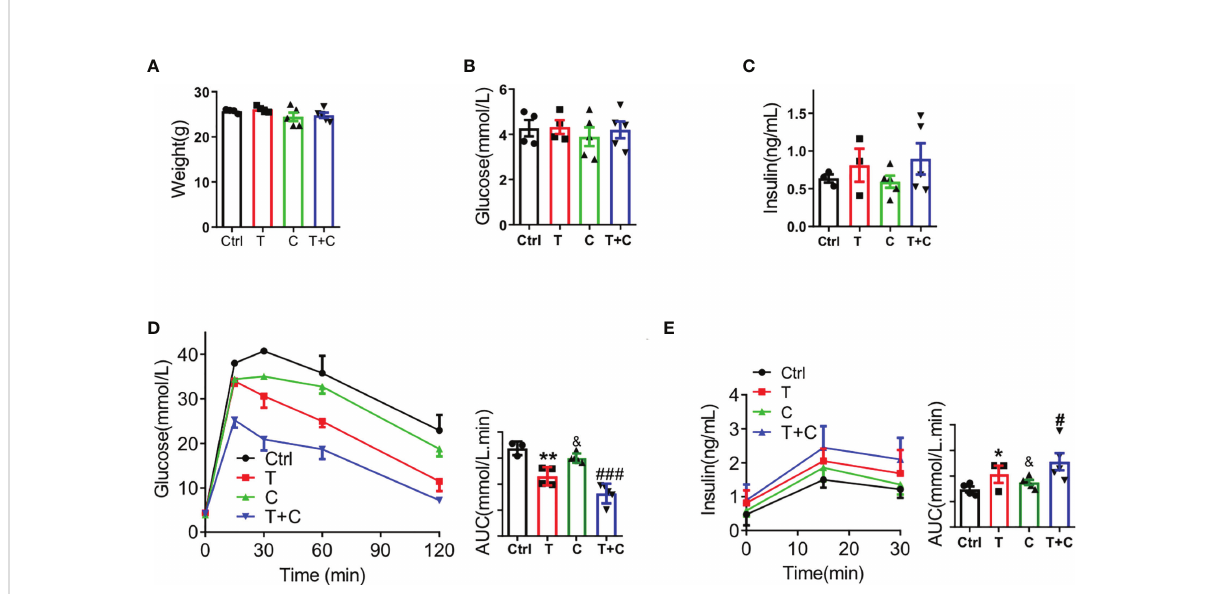
FIGURE 1 Cisapride combined with tolbutamide regulated glucose metabolism in wild-type mice Wild-type (WT) mice were divided based on (A) body weight, (B) fasting blood glucose and (C) fasting serum insulin. (D) Different drugs were administered transiently to WT mice, including the control (physiological saline, Ctrl), tolbutamide (T, 20 mg/kg), cisapride (C, 20 mg/kg) and tolbutamide combined with cisapride (T+C). Intraperitoneal glucose tolerance tests (IPGTTs) were performed in the 4 groups. (E) Intraperitoneal insulin release tests (IPIRT) were performed. n=6 for each group (A – E) & P < 0.05, ** P < 0.005, # P < 0.05 , ### P < 0.005 vs. Ctrl. Statistical comparisons were calculated using the Mann – Whitney U test (A – E)